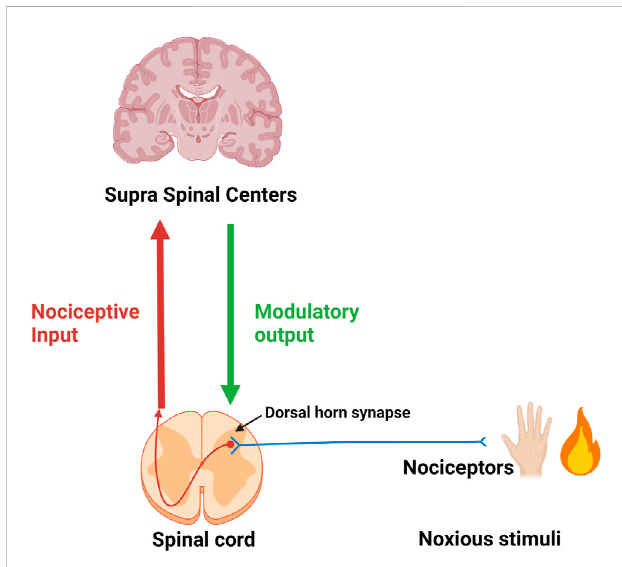
FIGURE 1 First neuron (in blue) of the ascending pain pathway. Red-brown arrow: Second ascending neuron leading to supra-spinal centers. Green arrow: Descending modulatory output from supra-spinal